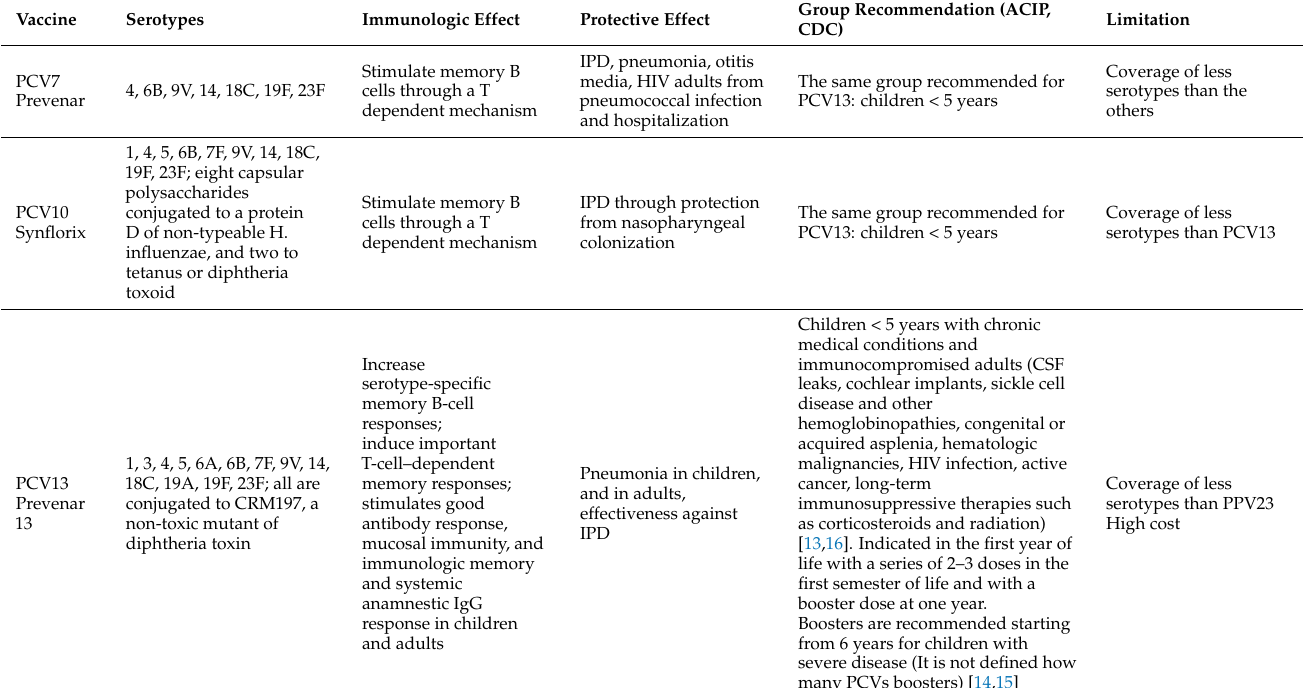
Table 1. Comparison between commercial vaccines and indications of